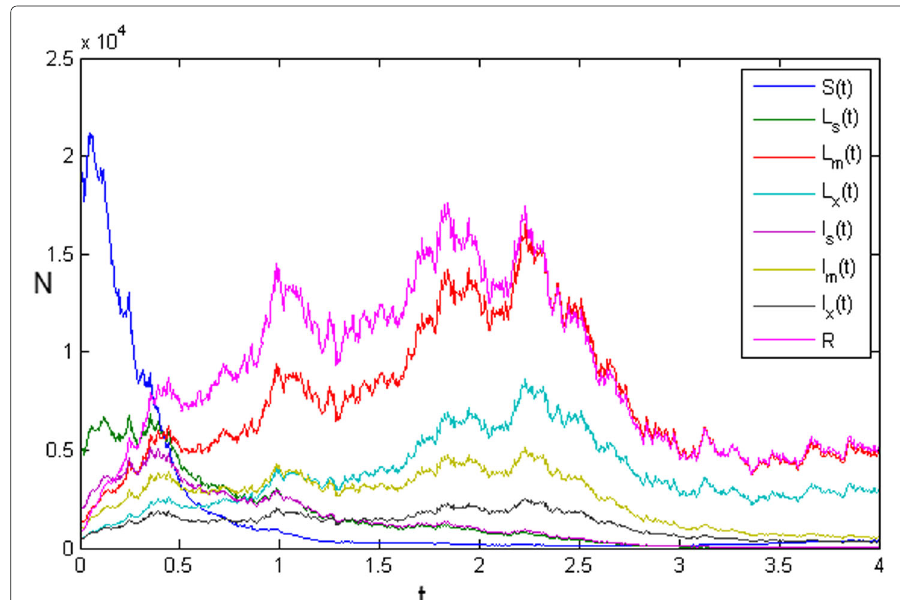
Fig. 2 Simulations of multi-strain TB model showing the various classes with θ = 0, ξ = 0.5